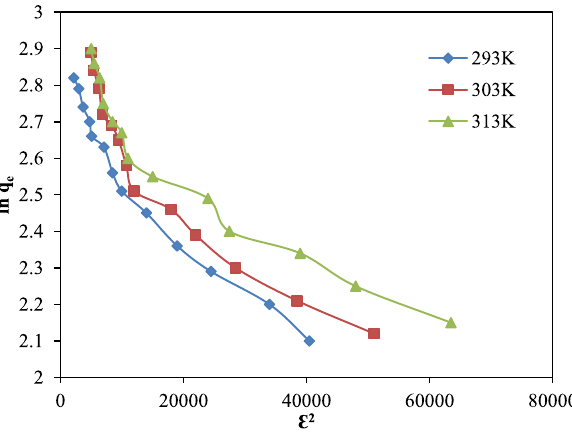
Fig. 13 Pseudo-first- and second-order rate kinetics for MR sorption onto SCTJF at 303